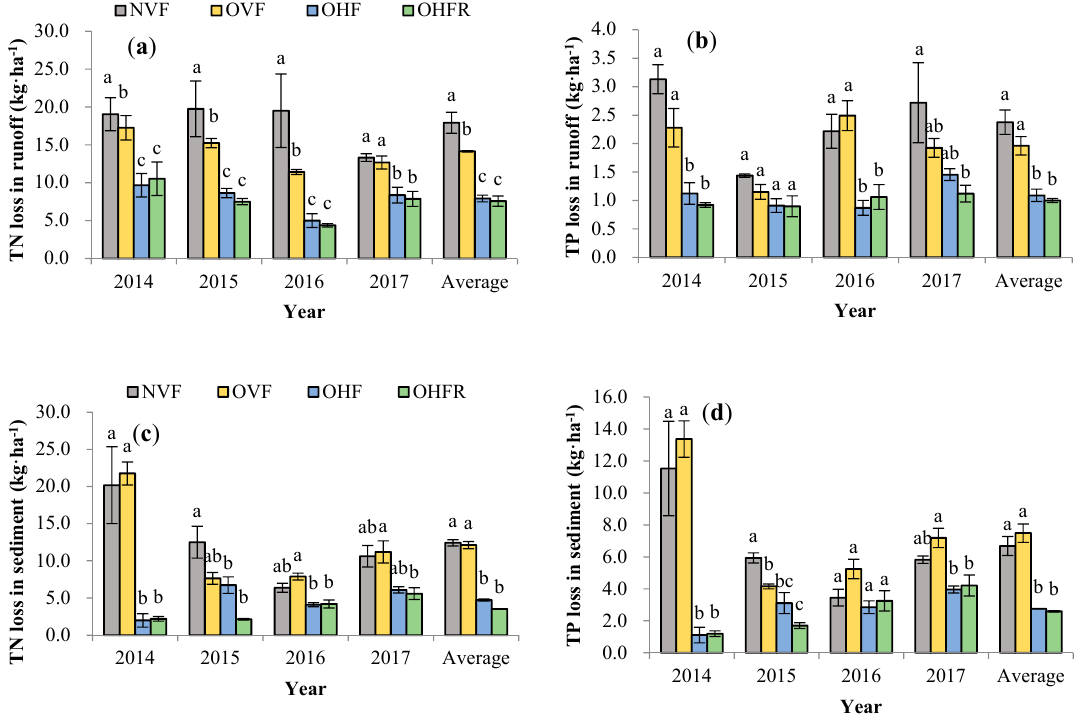
Figure 3. Annual total nitrogen (a and c) and total phosphorus loss (b and d) in runoff and sediment from trial plots during 2014–2017. Error bars represent ±standard errors.